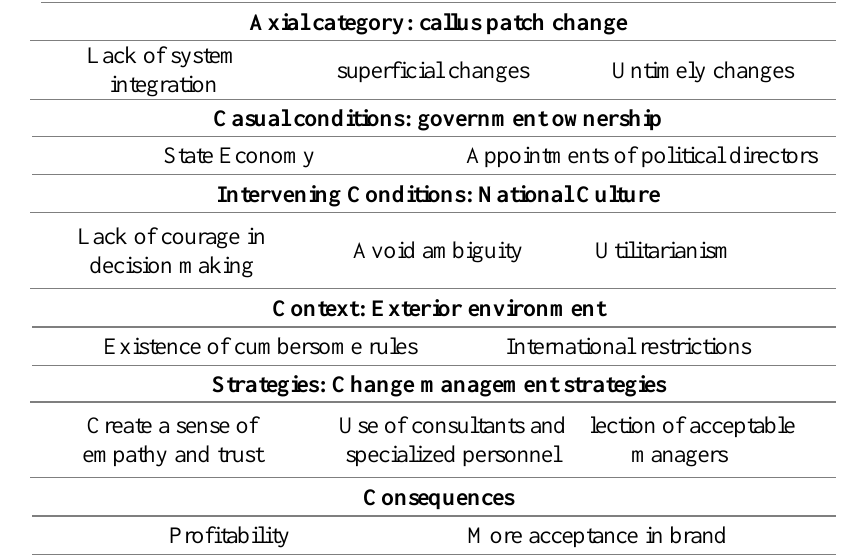
Table 3 - Six categories of foundation data